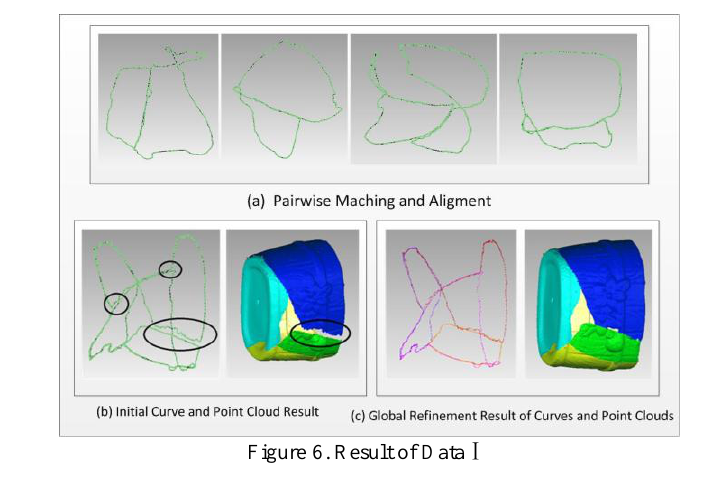
Figure 5. Experiment Data